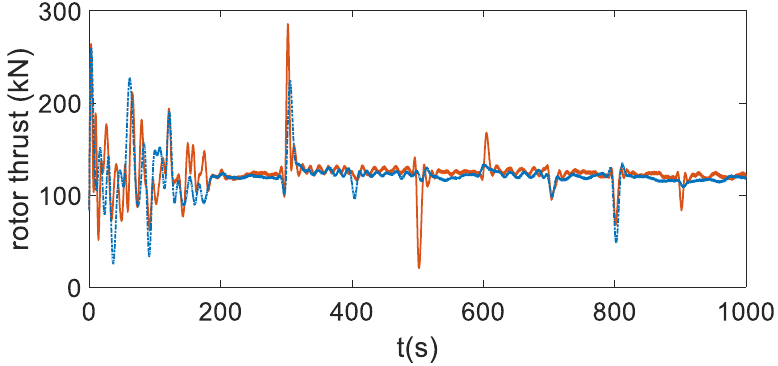
Figure 18. Response of rotor thrust of WPGS for the robust MPC (red solid line) and stochastic MPC (blue dotted line) using the FAST simulator.